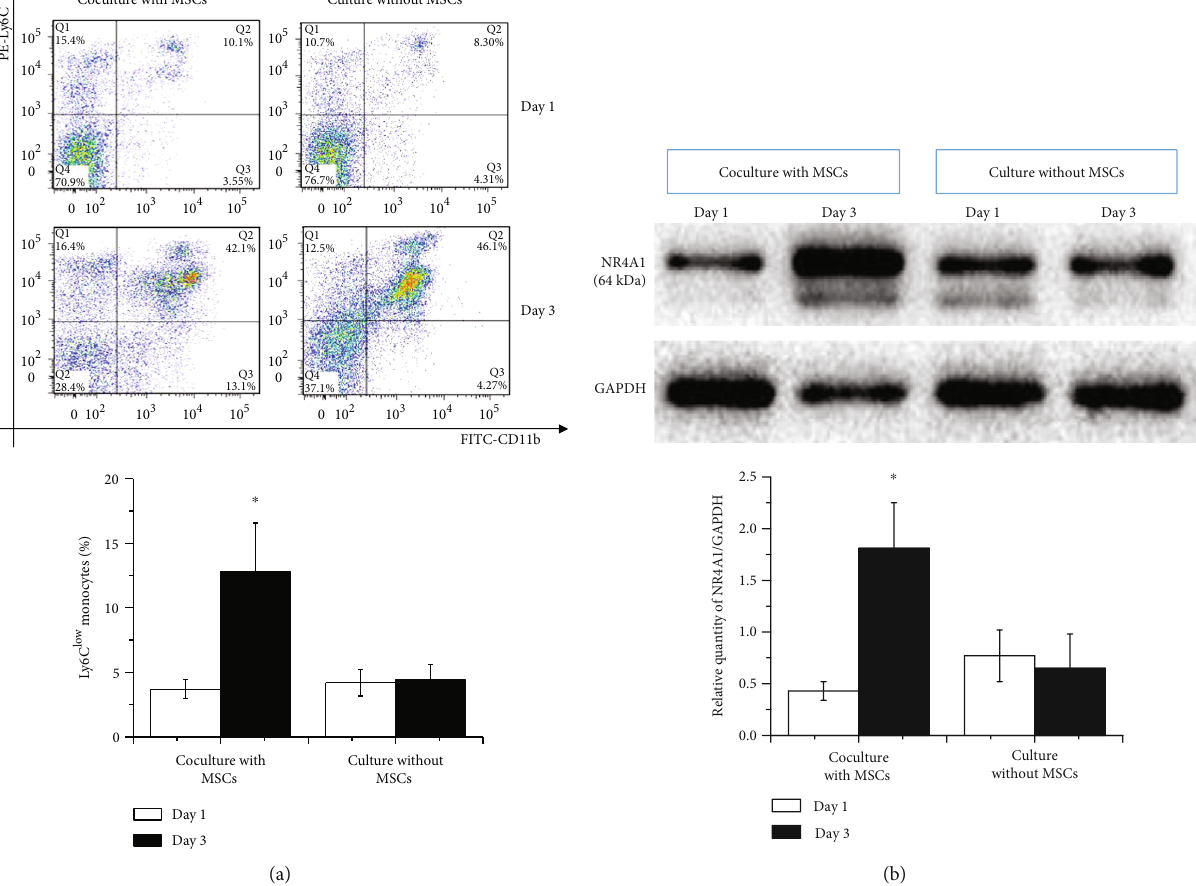
Figure 1: Conversion of Ly6C high to Ly6C low monocytes when cocultured with MSCs. (a) After stimulation with LPS (1 μ g/ml), monocytes were cocultured with or without MSCs (control). Ly6C low monocytes at day 1 and day 3 were then determined by FACS. (b) Expression levels of NR4A1 in two groups of Ly6C high/low monocytes (corresponding to (a)) were then tested. ∗ p < 0 : 05 at day 3 vs. the fi rst day. Abbreviations: FITC: fl uorescein isothiocyanate; MSCs: mesenchymal stem cells; PE: phycoerythrin; NR4A1: nuclear receptor subfamily 4 group A member